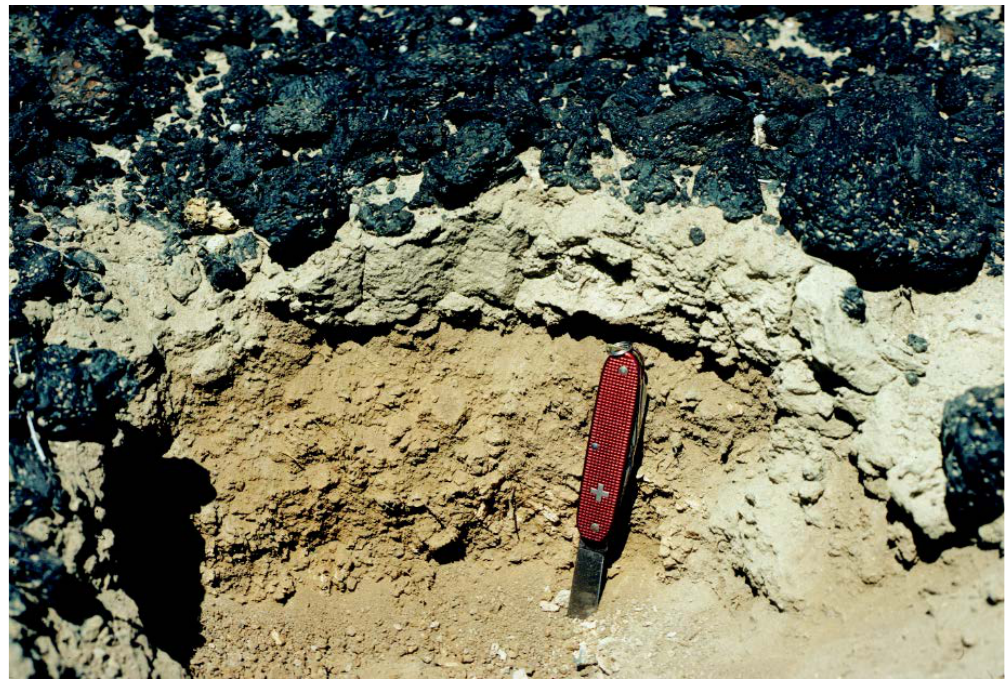
Figure 7. Upper portion of soil profile beneath a pavement of basalt clasts, Cima Volcanic Area, California, USA. Only the top 20 cm of the profile is pictured; soil depth exceeded 72 cm in the original description of this site (MP-27 in McFadden et al. [55]). The age of the basalt flow on which the soil and pavement formed is 260 ka (K-Ar dating of basalt). The 7 cm thick, light-coloured horizon directly above the pocket knife is the vesicular A horizon. Note the vertical faces of prismatic peds. Original colour recorded for this horizon is 10 YR 7/3. Behind the knife is the uppermost portion of a sequence of reddened Bt horizons; the colour is 7.5 YR 6/4.